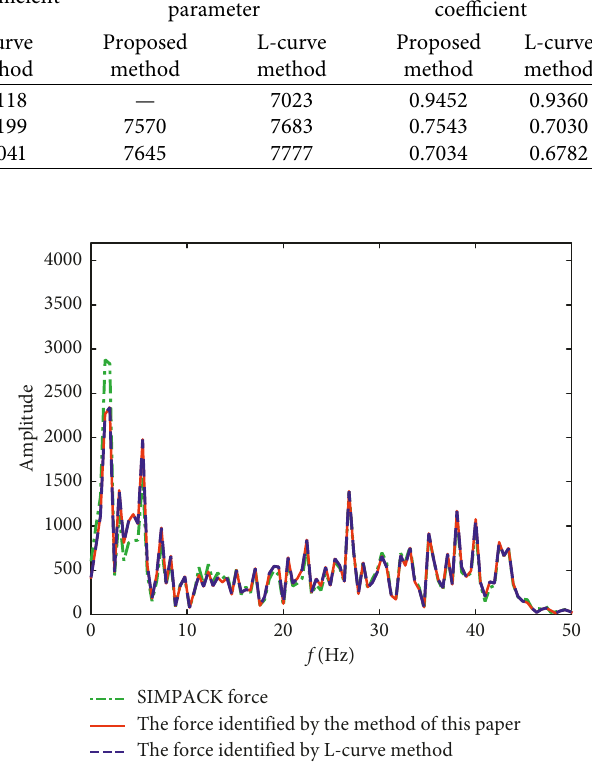
Figure 19: Amplitude-frequency curve of the two methods for F identification when the noise level is 0%. 2